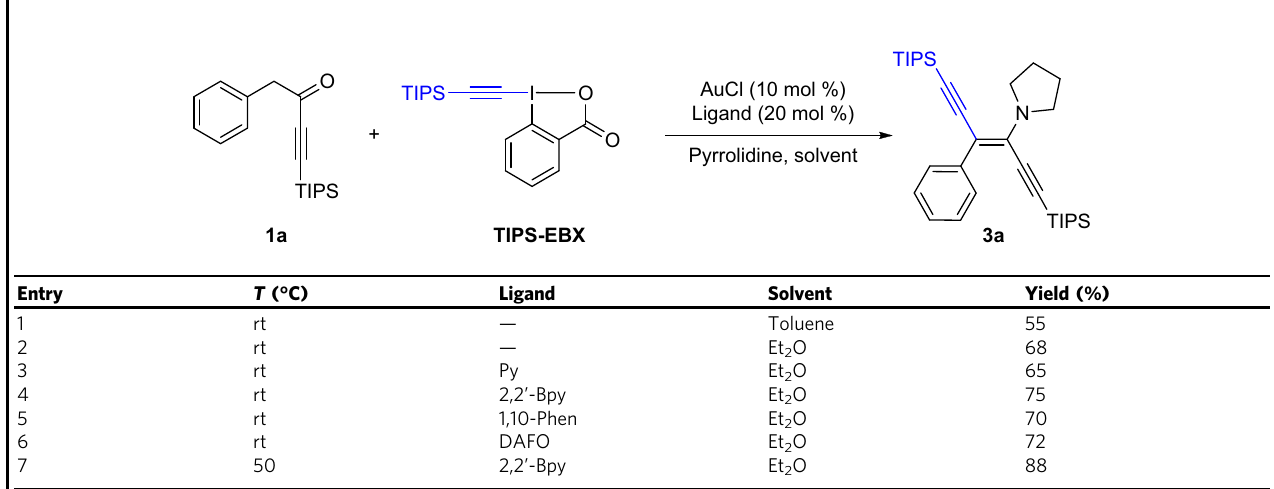
Table 1 Condition survey for the synthesis of diynenamines a,b